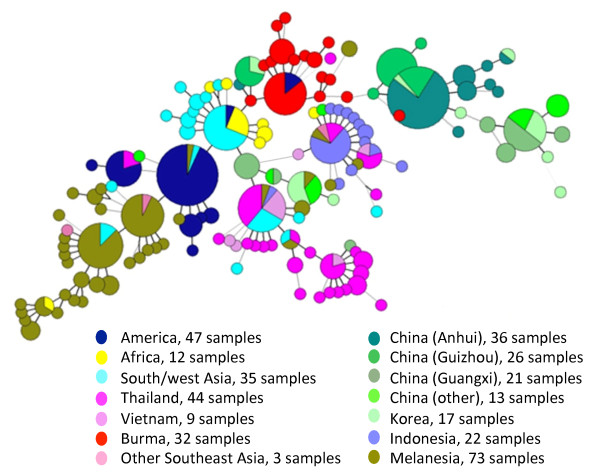
A haplotype network based on P. vivax mt genome sequences. Each circle represents a haplotype with size of the circle equaling to the frequency of the haplotype in the samples. Lines separating haplotypes represent mutational steps. Each color shows the countries of origin of the samples.